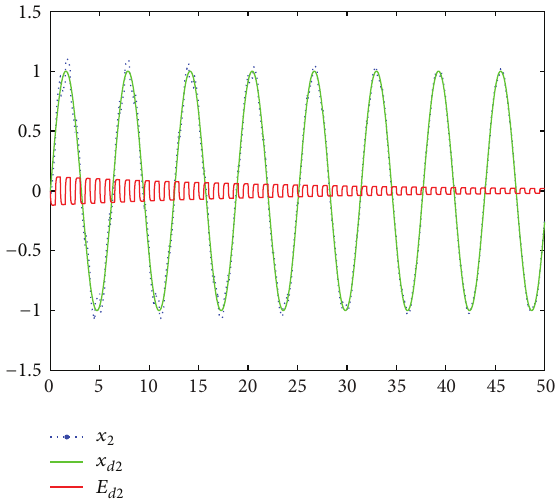
Figure 10: Trajectory tracking result for system state 𝑥 2 .